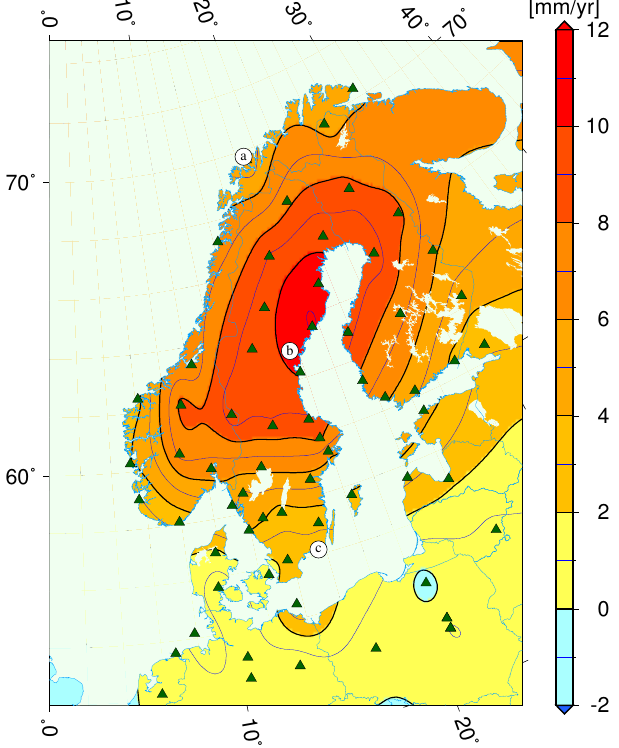
Figure 5. Present-day uplift rates in Fennoscandia as measured by GPS in the Bifrost project as processed by Lidberg et al. (2010). Triangles mark the location of the GPS stations; circles abbreviated with a, b and c show locations at which predicted uplift curves are displayed in Sect.